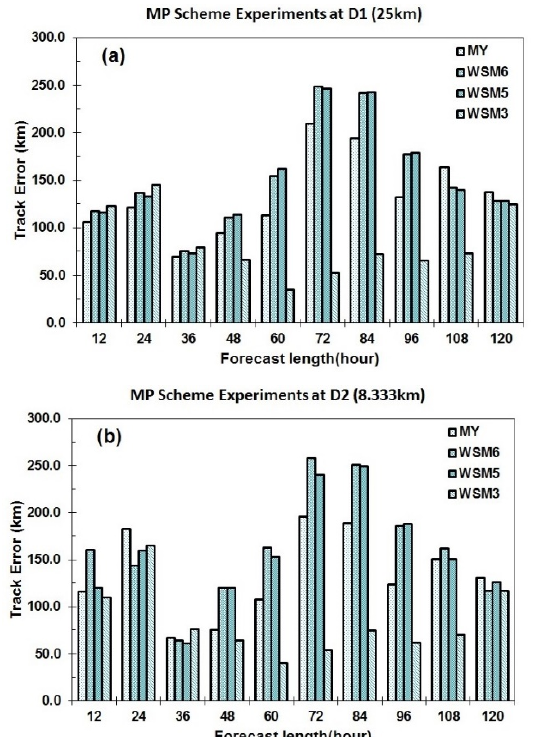
8 Figure 3. Model-simulated track positions of Phailin during 00 UTC, 08 October to 06 UTC, 13 Oc- tober 2013 using 00 UTC, 08 October 2013 as initial conditions. The positions were identified through the minimum sea level pressure from different WRF experiments along with IMD observations. The simulated track positions from DD to VSCS have deviated to the east and north of the IMD observation. However, following later landfall of VSCS, positions of simulated tracks were located west of the IMD observed track. From the model experiments, the initial location of the simulated tracks may have shifted relative to observations [39,51]. The track errors from different MP scheme experiments were drawn using the formula from [52] and are shown in Figure 4. The simulated track errors from the MP experiments from domain 1 (D01: 25 km) and domain 2 (D02: 8.333 km) resolutions indicate the sensi- tivity of tracks in terms of resolutions. The track errors during the simulations were found to vary, as shown in Figure 4a,b. The average number track errors over 12 h was lower in